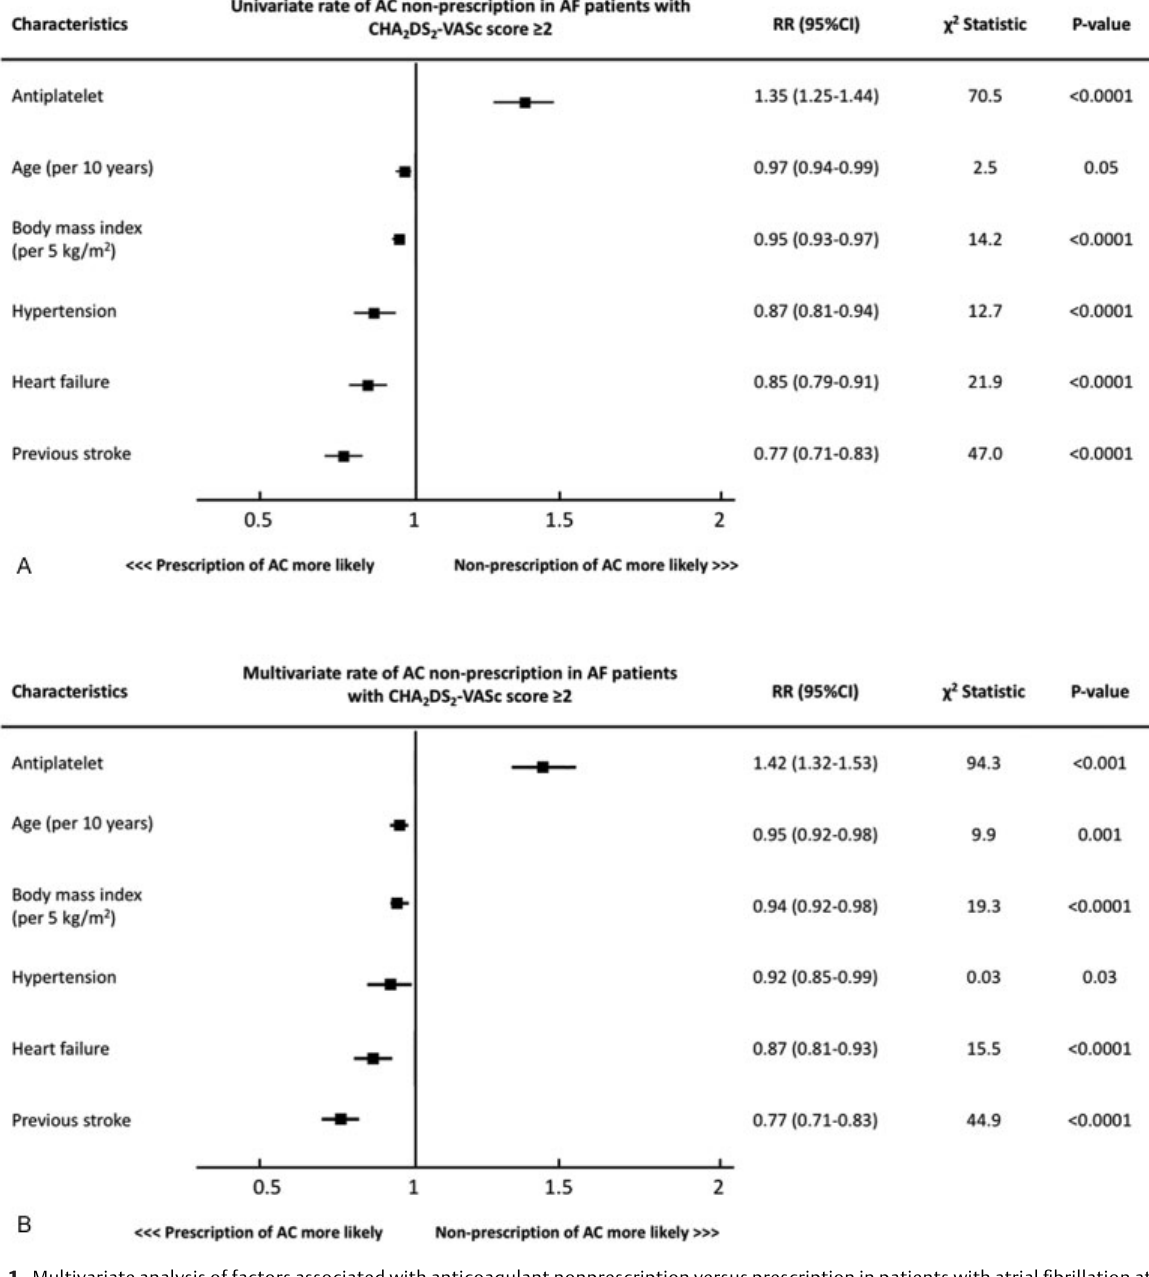
Fig. 1 Multivariate analysis of factors associated with anticoagulant nonprescription versus prescription in patients with atrial fi brillation at risk of stroke (CHA 2 DS 2 -VASc score (cid:1) 2). AC, anticoagulant; AF, atrial fi brillation; CI, con fi dence interval; RR, relative